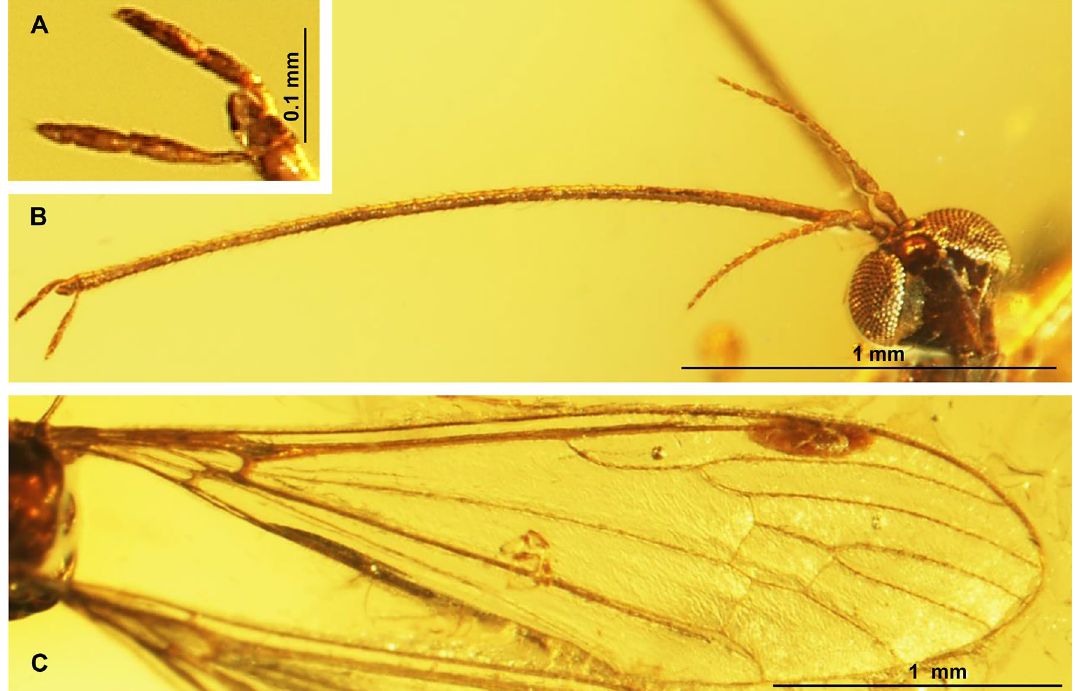
Figure 4. Elephantomyia (s. str.) christelae sp. nov. No. CCHH 874–2 (male), coll. Ch. & H. W. Hoffeins, holotype, photographs: ( A ) palpi; ( B ) head; ( C )